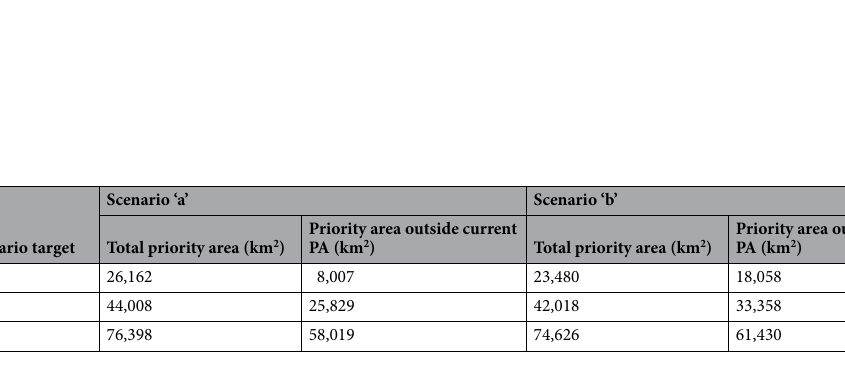
Table 1. Size of the priority area (for planning units with a selection frequency > 75) in scenarios ‘a’ and